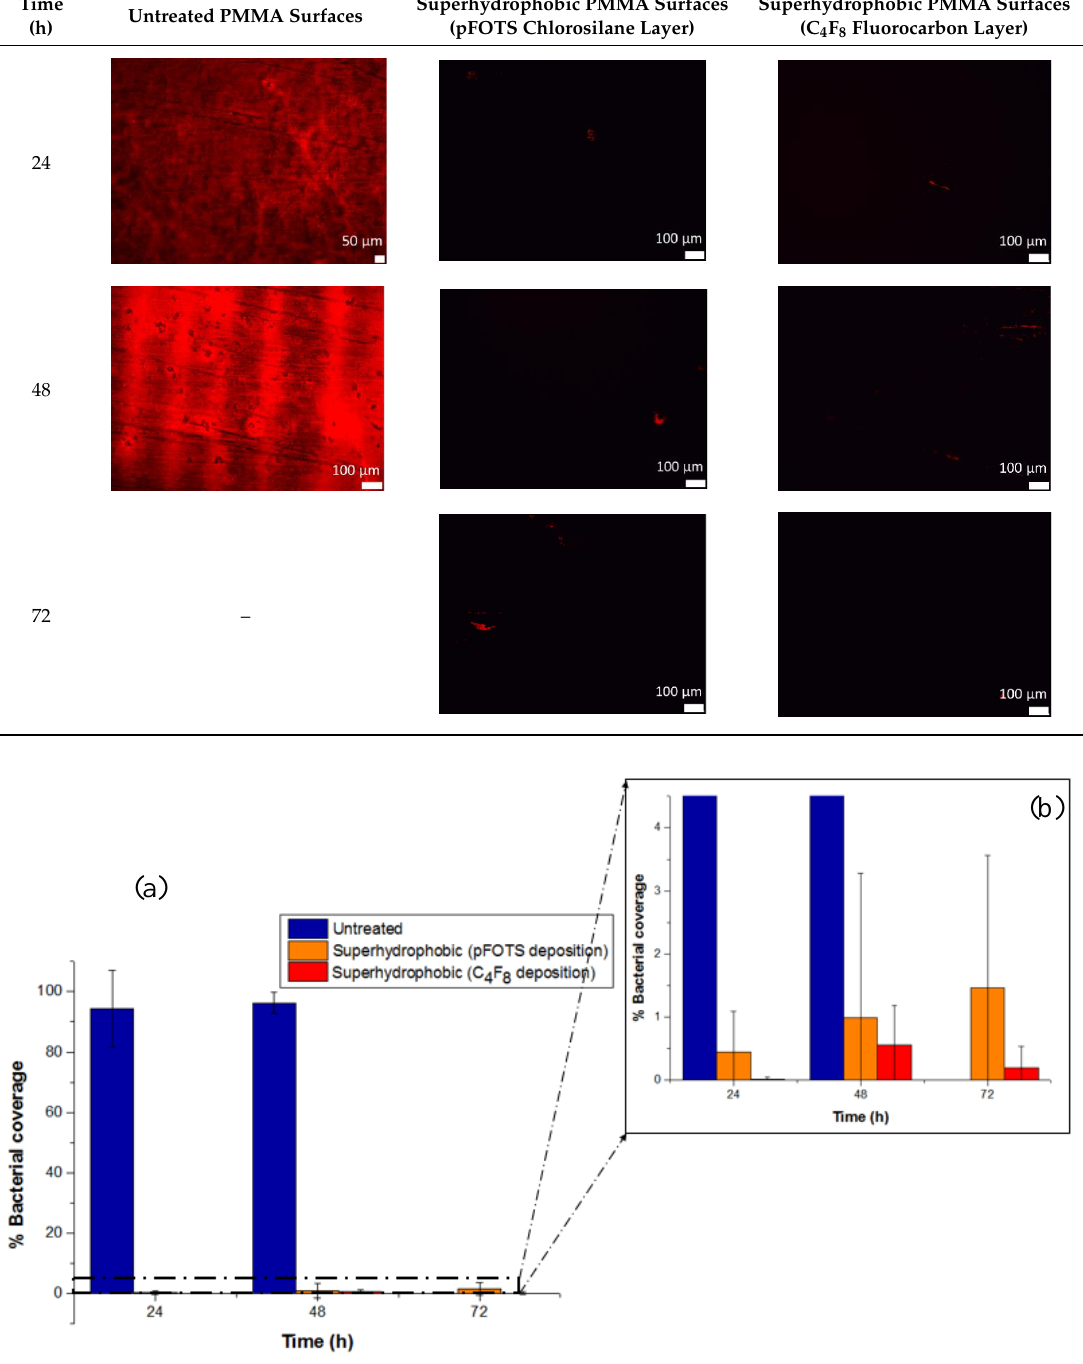
Table 2. Fluorescence microscope images of bacterial propagation on three different surfaces, i.e., untreated PMMA, and superhydrophobic deposited with either chlorosilane layer from pFOTS solution, or fluorocarbon layer from C 4 F 8 plasma micro-nanotextured PMMA surfaces, during the 72-h bacterial adhesion study (2.3 × 10 9 cfu/mL).